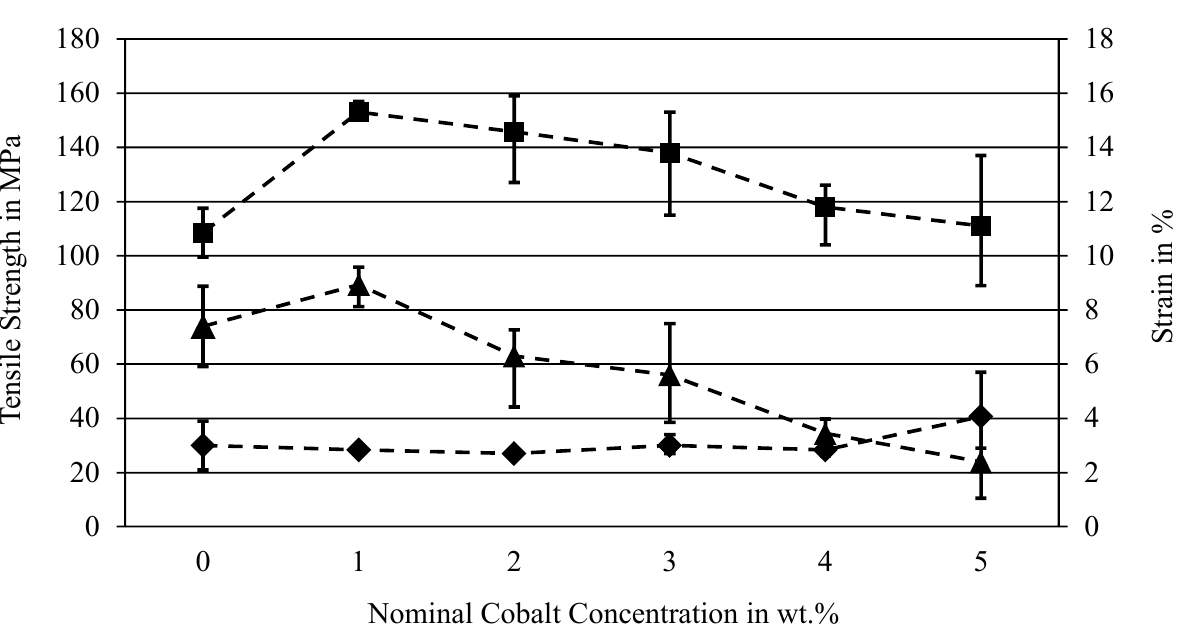
Figure 6. Mechanical properties of binary Mg-Co alloys in the as-cast state subject to the Co content; tensile tests according to ISO 6892-1, threaded tensile specimens DIN 50125 B 6 × 30 (mean values of 3 specimens for each alloy).